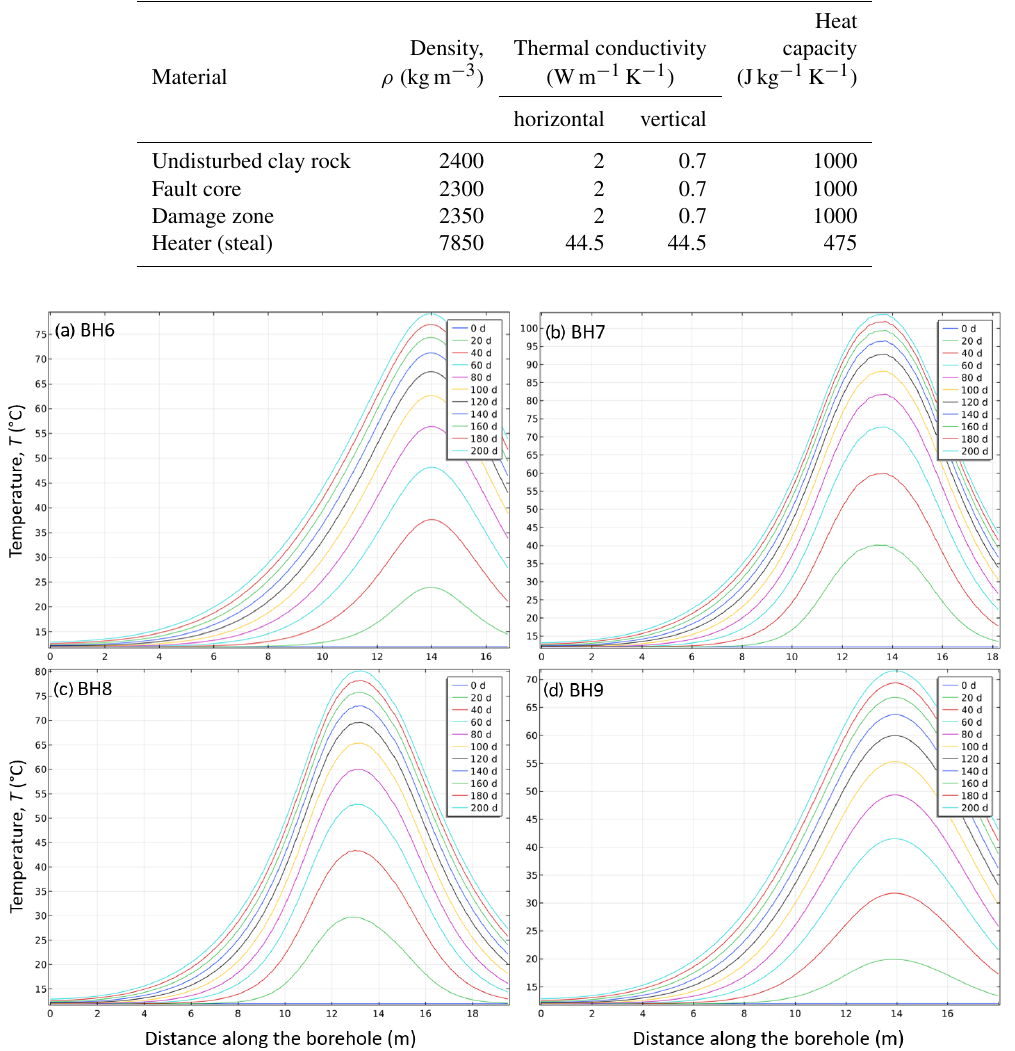
Figure 8. Evolution of the temperature along the heating boreholes (BH6 to BH9, panels a to d respectively) during the thermal